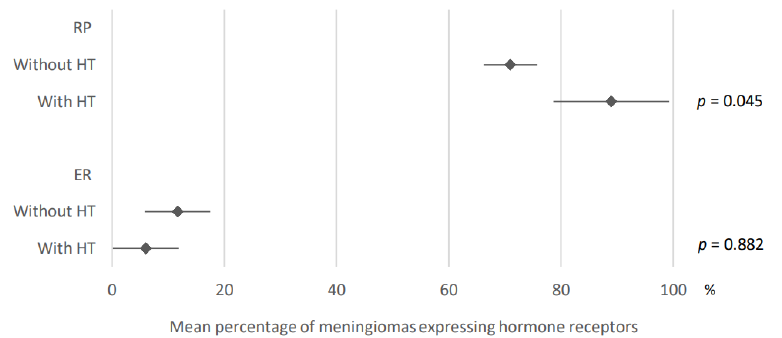
Figure 7. Comparison of hormone receptors expression in meningiomas developed under hormonal treatment versus without. PR: progesterone receptors; ER: estrogen receptors; HT: hormonal treat- ment. The results are expressed as a mean associated with their 95% confidence interval. Number of